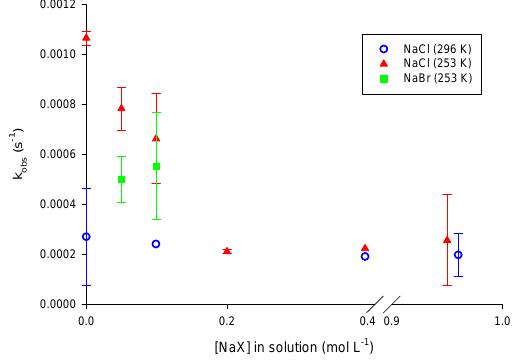
Figure 3 Fig. 3. The solid trace shows an absorption spectrum of harmine in Figure 4 Fig. 4. Observed rate constants for harmine photolysis as a function room temperature aqueous solution; the crosses indicate an excita- of salt concentration: In aqueous solution at room temperature (hol- tion spectrum of harmine at an air-ice interface at 253K. low blue circles); at the surface of frozen aqueous NaCl solutions at 253K (solid red triangles) and at the surface of frozen aqueous NaBr solutions at 253K (solid green squares). Error bars represent the uncertainty about the mean for at least three